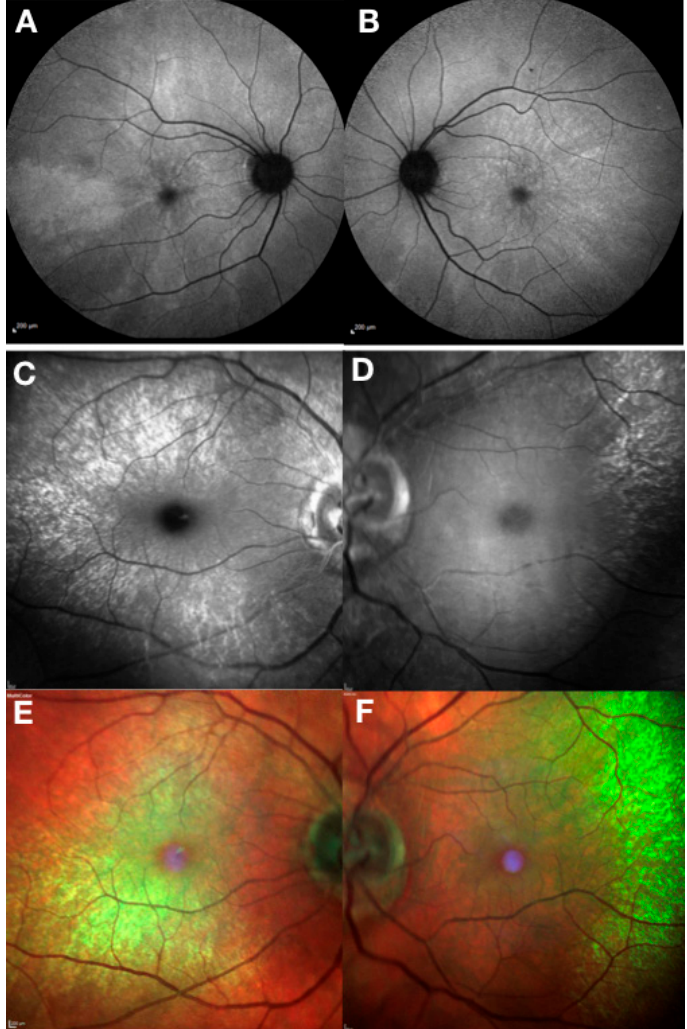
Figure 3. Clinical phenotype of RPGR female carriers. Fundus autofluorescence (Heidelberg) showing a typical macular radial pattern or ‘tapetal’ reflex in a female carrier of an RPGR mutation ( A , B ). Random X-chromosome inactivation generates clones of normal or affected photoreceptors giving rise to this mosaic pattern. Blue reflectance ( C , D ) and multicoloured ( E , F ) modes using Heidelberg scanning laser ophthalmoscope can be very helpful in showing the macular reflex.